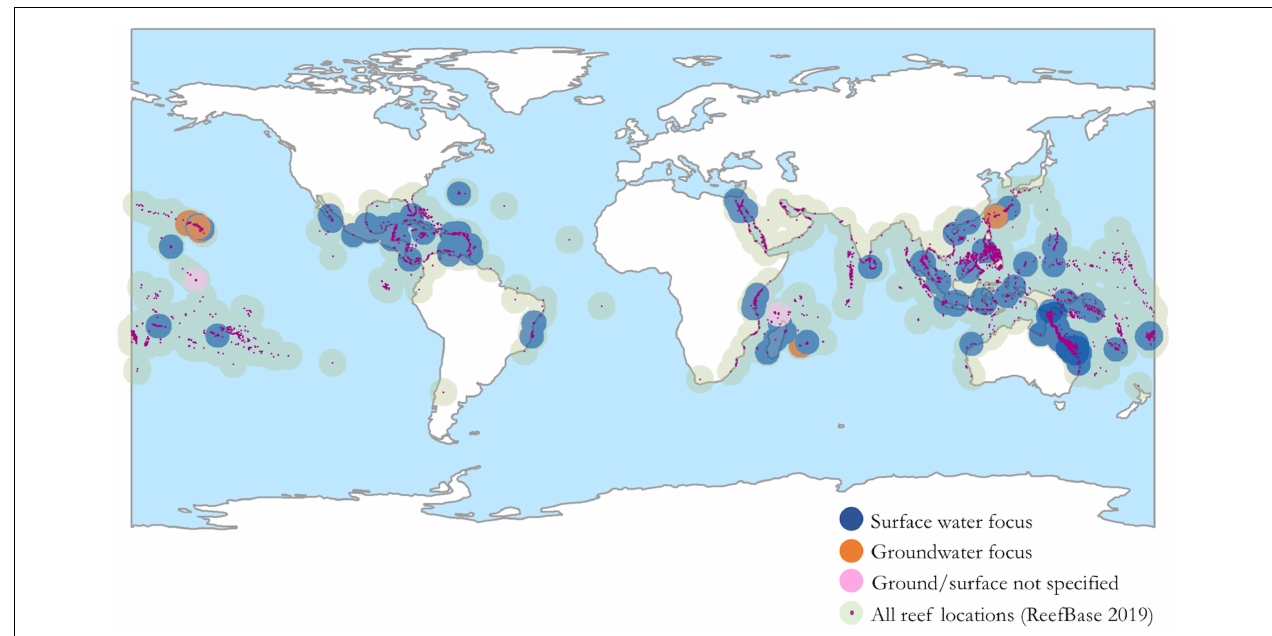
FIGURE 1 | A map of current ridge-to-reef studies delineated by primary land-reef vector: surface flow or groundwater discharge. References for mapped studies can be found in Supplementary Material